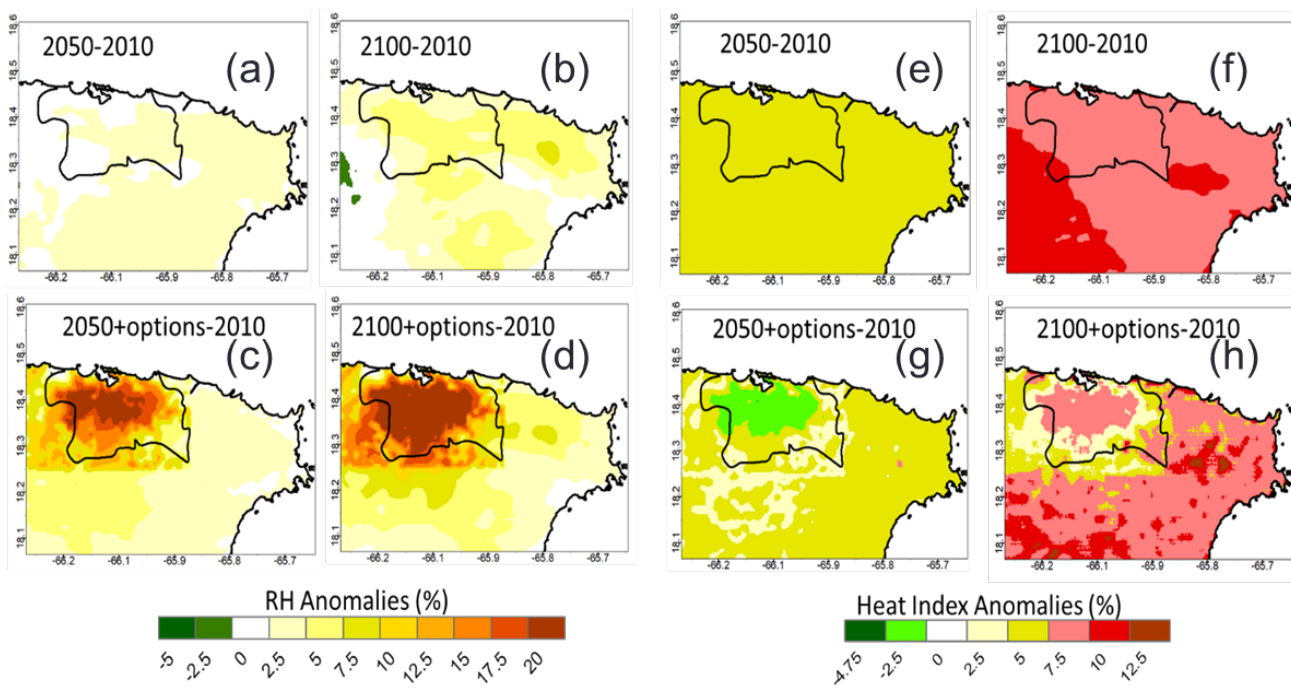
Figure 7. Relative humidity (RH) anomalies for 2050 ( a ) RH anomalies for 2100 ( b ) and RH anomalies with mitigation option for 2050 ( c , d ) RH anomalies with mitigation option 2100; Heat index anomalies for 2050 ( e ) 2100 ( f ) and heat index anomalies for 2050 with mitigation options ( g ) and heat index anomalies for 2100 with mitigation options 2100 ( h ).